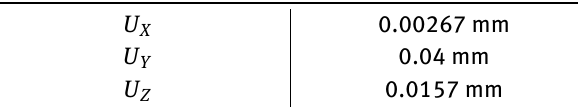
Figure 11: Forces applied to the polar expansions to perform the FEM simulations. Table 2: Forces Applied to the Polar Expansions. F X 0 N F Y F Z Table 3: Maximum Displacements of the System Base-Polar Expan- sions Joined by